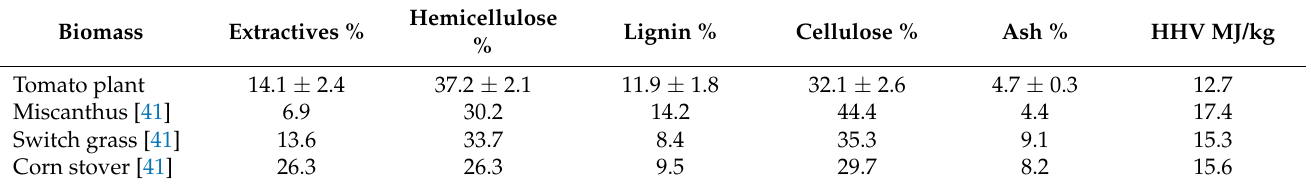
Table 1. Fiber analysis results of tomato plant biomass in mass (%) and comparison with other biomasses. Biomass Extractives %